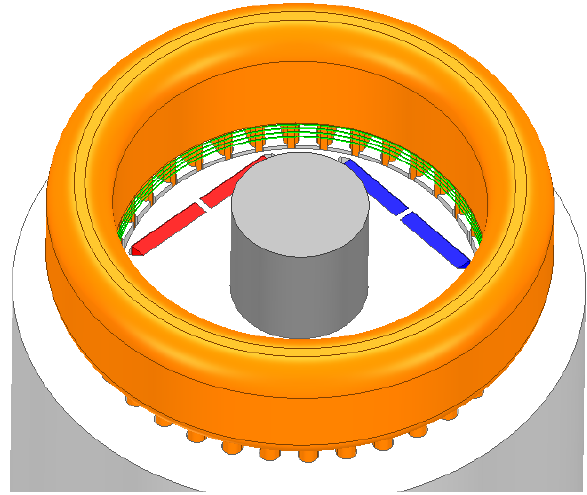
Figure 14. A 3D model with a shielding winding in the form of a helix placed under the stator end-winding.